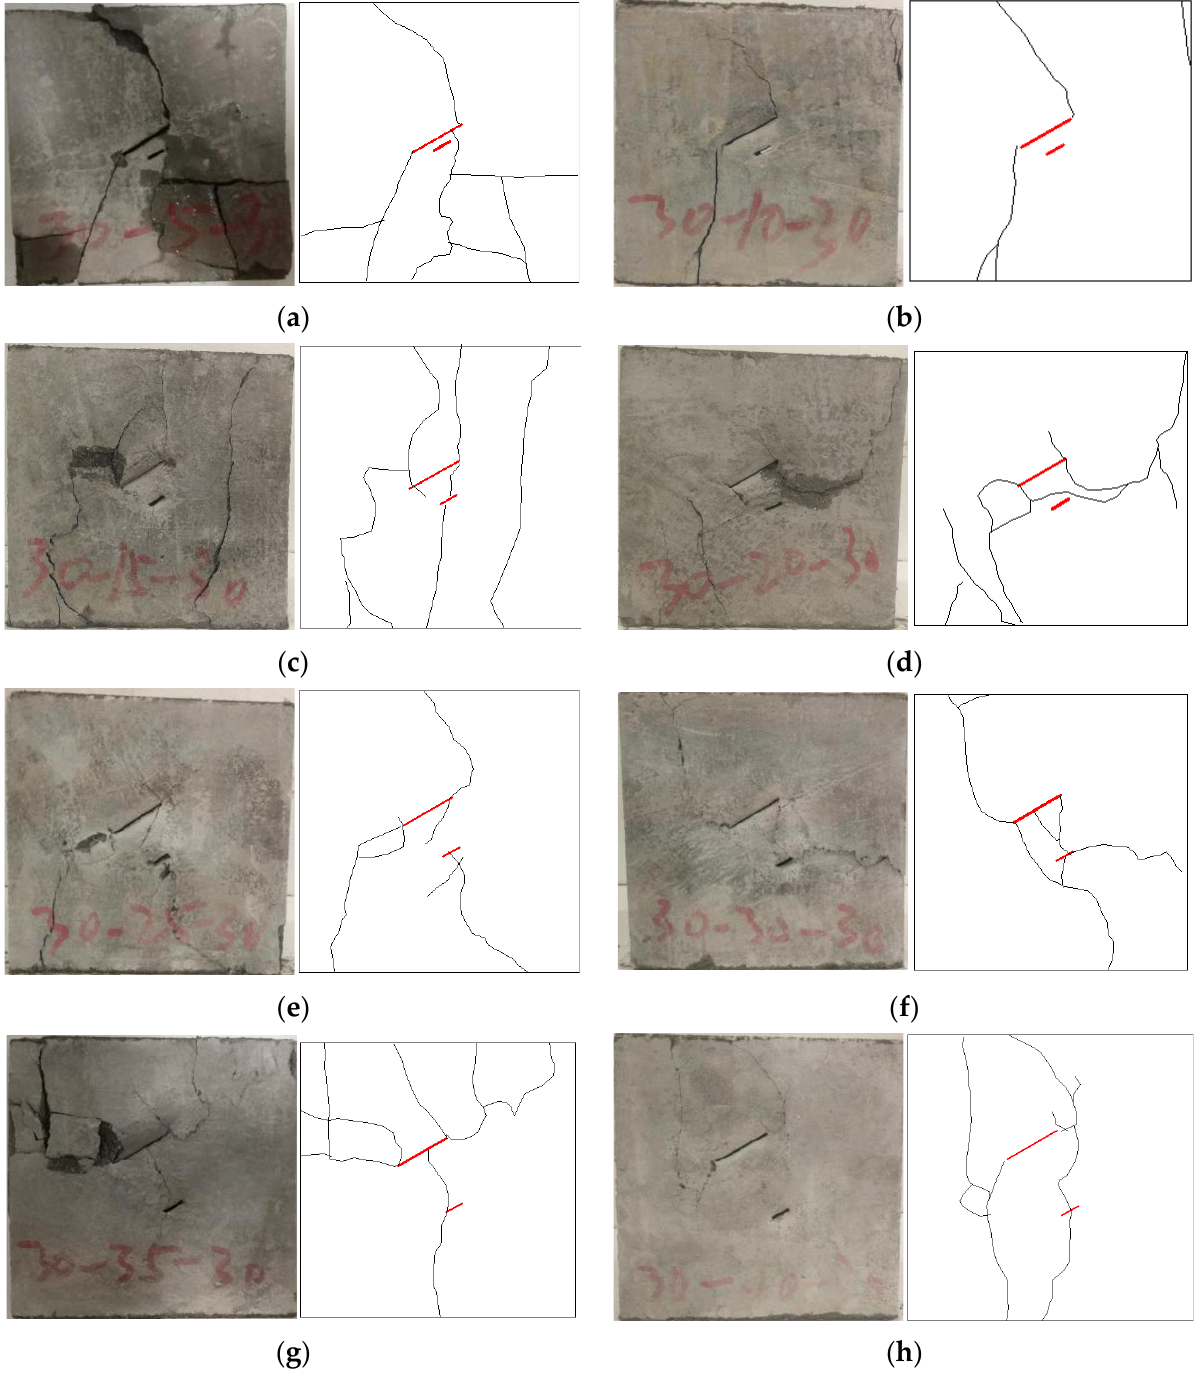
Figure 9. Influence of fissure distance on crack propagation and coalescence. ( a ) Failure specimen 30-5-30; ( b ) 30-10-30; ( c ) 30-15-30; ( d ) 30-20-30; ( e ) 30-25-30; ( f ) 30-30-30; ( g ) 30-35-30; and ( h ) 30-40-30.